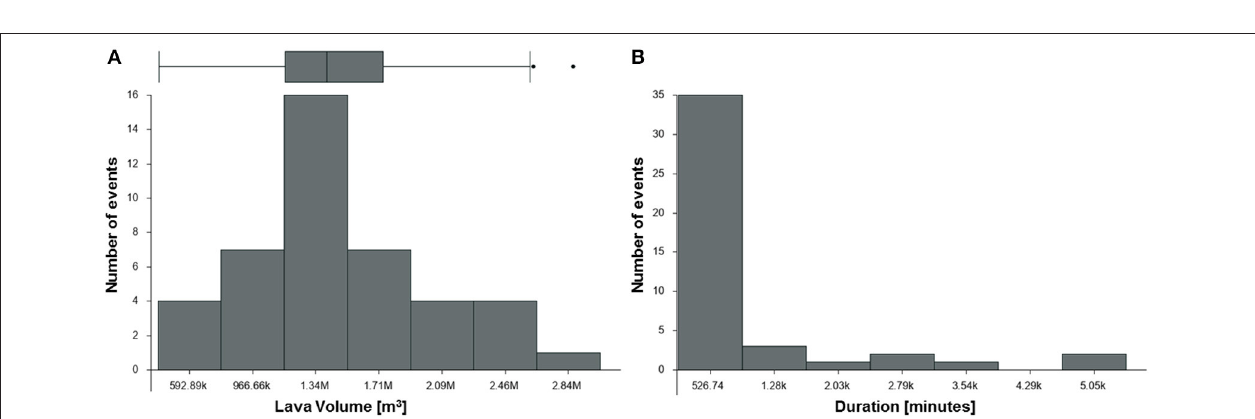
FIGURE 9 | Statistical analysis on SEVIRI-derived results, excluding the two longer effusive events of 2014. The distribution of lava volumes against the number of events is a skewed Gaussian peaked on 1.34 millions of cubic meters, with quartiles 1.15 × 10 6 m 3 (25%), 1.4 × 10 6 m 3 (50%), 1.73 × 10 6 m 3 (75%) and outlier fences at 0.28 × 10 6 m 3 and 2.6 × 10 6 m 3 as illustrated in the box plot (A) . The durations follow a Pareto distribution with 76% of events lasting around 500min (B) .